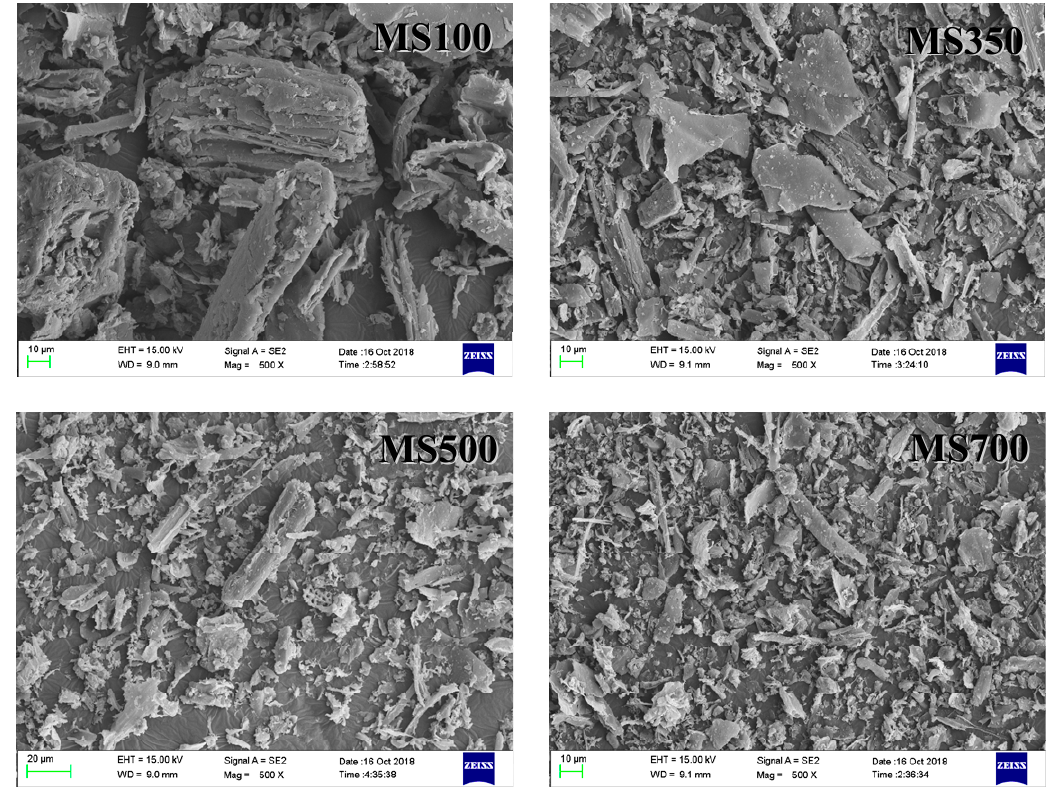
Figure 3. The SEM images of biochar.